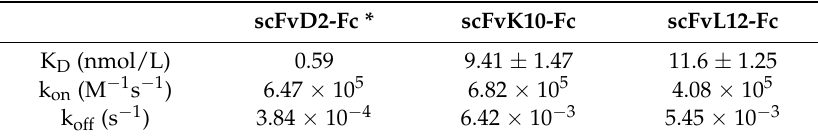
Table 1. Kinetic parameters of scFv-FGFR1 interaction measured with SPR. Sensor-immobilized FGFR1.D1-D2-D3-Fc was incubated with various concentrations of scFv-Fc proteins and kinetic parameters (ka, kd, and K D ) were determined using BIAevaluation 4.1 software. * values from [16]. K D errors represent standard